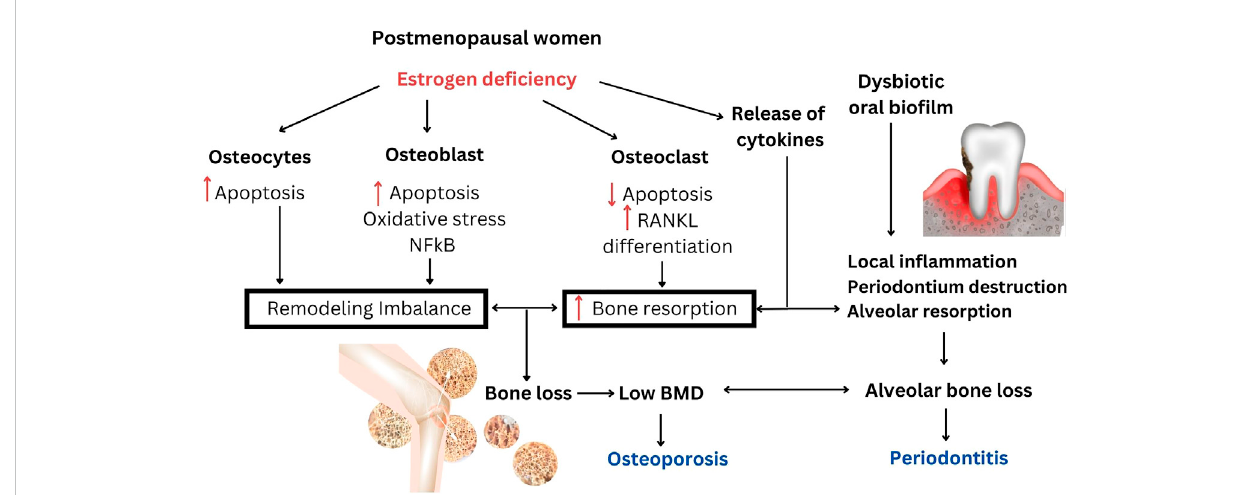
FIGURE 1 The impactof estrogen de fi ciency and theassociation betweenpostmenopausal osteoporosis and periodontitis. Estrogen de fi ciency isresponsible for the increase in systemic bone resorption and remodeling imbalance that would also accelerate the increase in alveolar bone resorption. Loss of BMD in postmenopausal osteoporosis may be responsible for increasing alveolar bone loss in periodontitis. Local in fl ammation in periodontitis may activate systemic osteoclastogenic cytokines and further aggravates bone